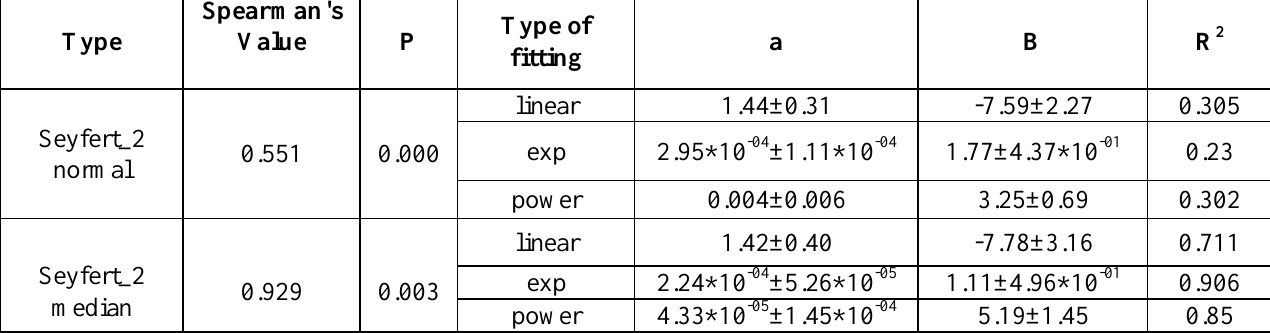
Table 4: Best fitting parameters for Syfert2